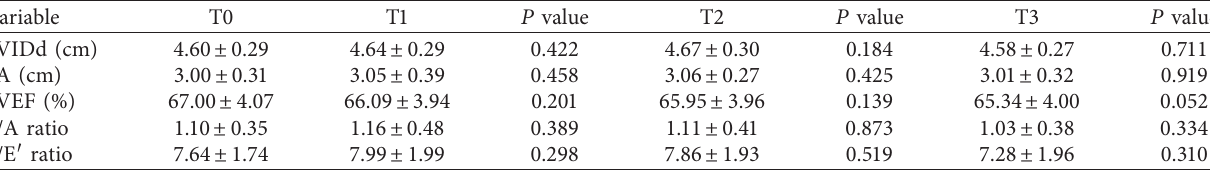
Table 2: Echocardiographic parameters before and at each follow-up point during chemotherapy in breast cancer patients. Variable T0 T1